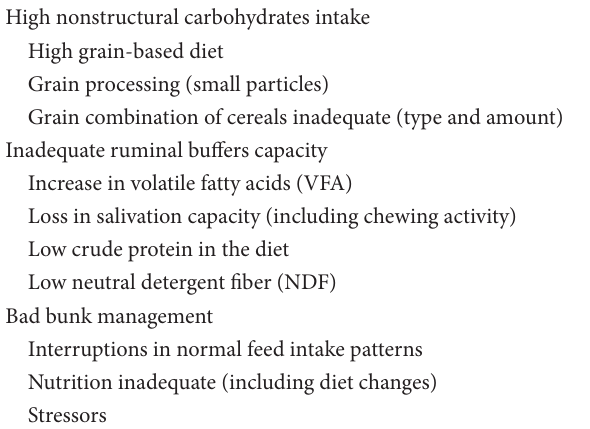
Table 2: Main causes of ruminal acidosis in feedlots. High nonstructural carbohydrates intake High grain-based